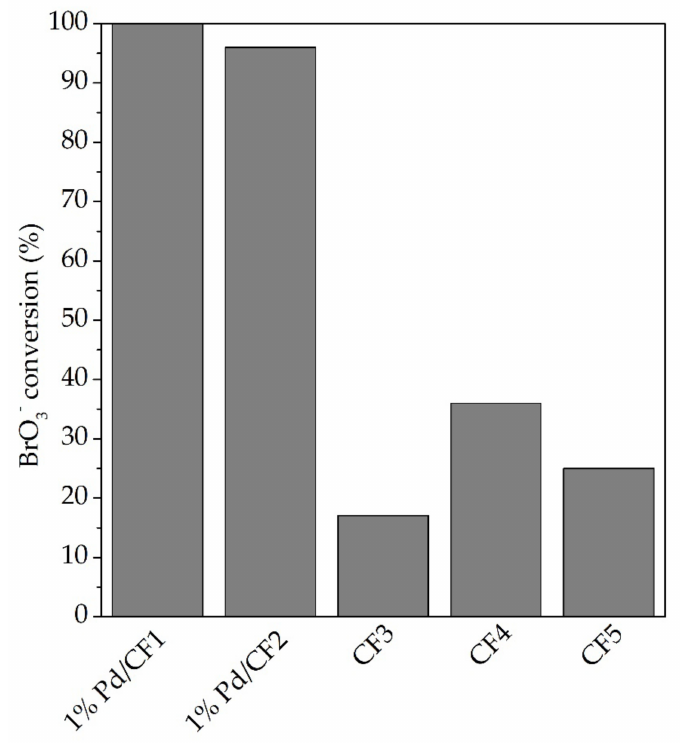
Figure 6. BrO 3 − conversion after 30 min of reaction of each tested